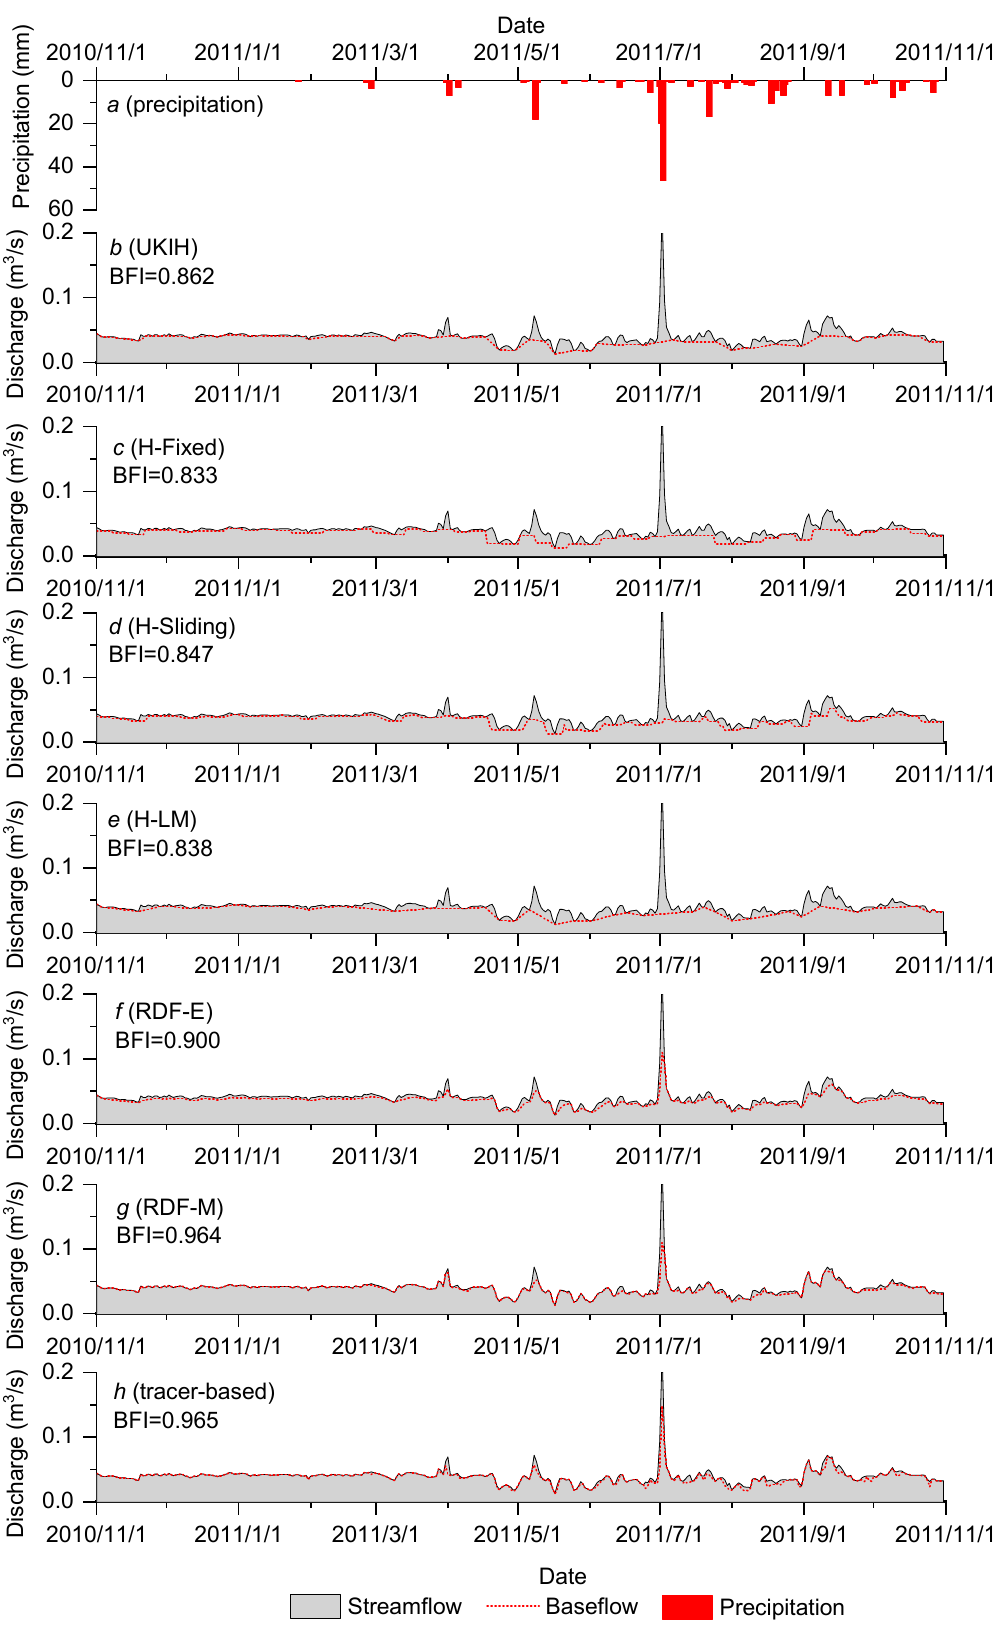
Figure 8. Scattered comparison of baseflow obtained by di ff erent baseflow separation Figure 8. Comparison of baseflow variation process obtained by different baseflow separation methods ( a ) precipitation, ( b ) UKIH, ( c ) H-Fixed, ( d ) H-Sliding, ( e ) H-LM, ( f ) RDF-E, ( g ) RDF-M, ( h ) tracer-based method.